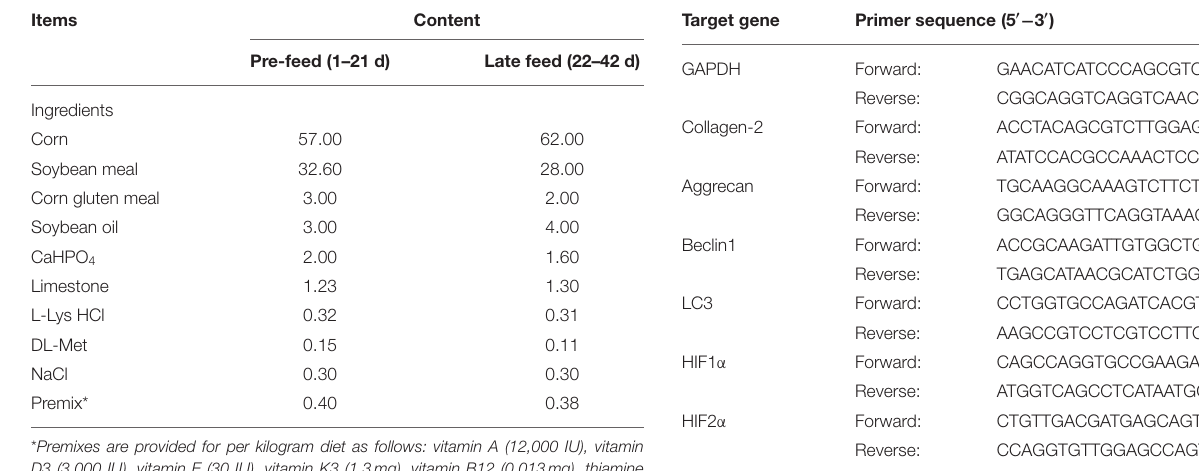
TABLE 2 | Primer sequences in qRT-PCR used to amplify relative mRNAs. Target